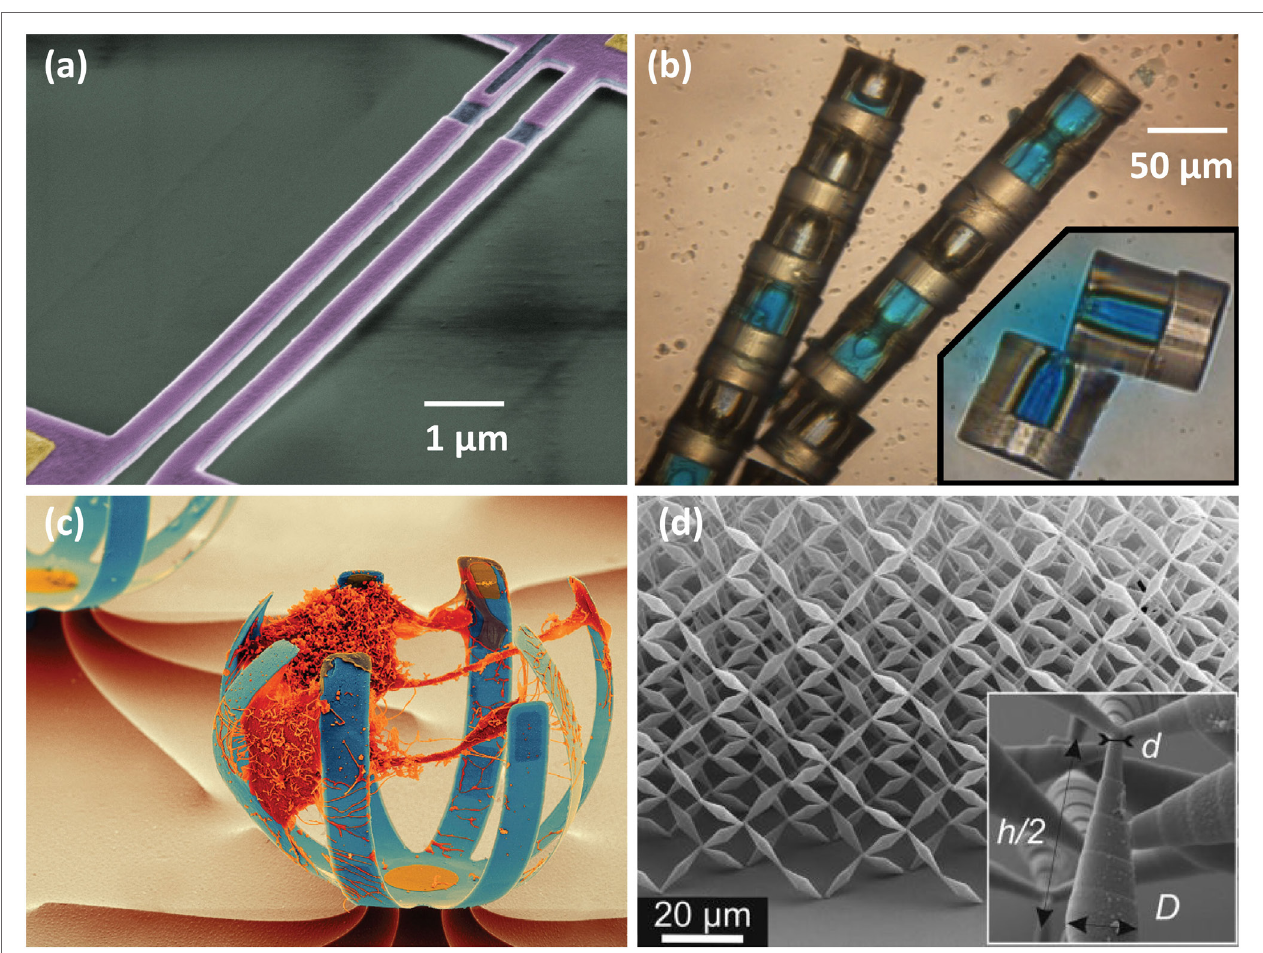
FiGUre 2 | State of the art for micro- and nano-mechanical devices in research. (a) Scanning electron microscope (SEM) micrograph of two NEMS clamped-clamped beams. The beams are mechanically coupled through the ledge present in the anchoring region and they are fabricated using a combination of metal and piezoelectric layers, which provide the devices with self-sensing and actuating capabilities. These devices are used as coupled resonators to study complex dynamics in the nanoscale (Villanueva et al., 2011, 2013) and they also have potential for noise reduction in communications (Kenig et al., 2012) and sensitivity increase for sensing (Spletzer et al., 2006). Color has been artificially added for illustration purposes. (B) Optical microscope picture of an assembly in liquid medium of hollow half-cylinders fabricated in SU-8. Fluidic self-assembly is one of the promising novel ways that can be used to assembly MEMS/NEMS devices in large scale (Goldowsky et al., 2013; Jacot-Descombes et al., 2013). The coupled cylinders shown in the figure could be used, for example, as microcapsules for drug storage and subsequent local drug release. (c) SEM micrograph of sets of metallic cantilevers with an engineered intrinsic stress gradient in order to obtain the curvature of the cantilevers and the cage-like structures. These cages can be used to capture cells and study their behavior as a function of different cage stiffness (Marelli et al., 2014). This example is an illustration of 2.5-D MEMS devices, where shapes and structures are designed to come out of the plane, as opposed to standard planar technology. Color has been artificially added for illustration purposes. Reproduced by permission of The Royal Society of Chemistry . (d) SEM micrograph of a polymer-based mechanical metamaterial fabricated using 3D printing in the nanoscale (Kadic et al., 2012). Metamaterials are artificially fabricated periodic structures that extend over long periods of space in 1, 2, or 3 dimensions that confer the overall extended pattern of special properties that, in most cases, cannot be found in reality. The mostly studied metamaterials are those giving rise to negative optical refractive indexes (these can be used to engineer invisibility cloaks) (Schittny et al., 2015) and those giving rise to negative Poisson’s ratios or negative mass-density tensors, for example, to engineer dilatational materials (Kadic et al., 2012). Reprinted with permission from AIP Publishing